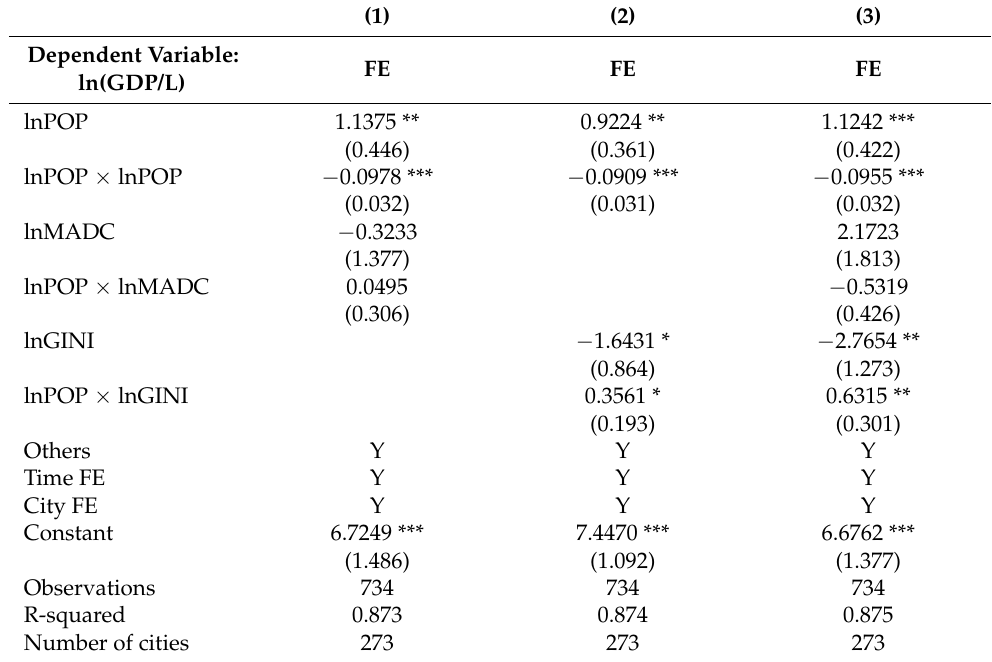
Table 6. Robustness to urban spatial structure